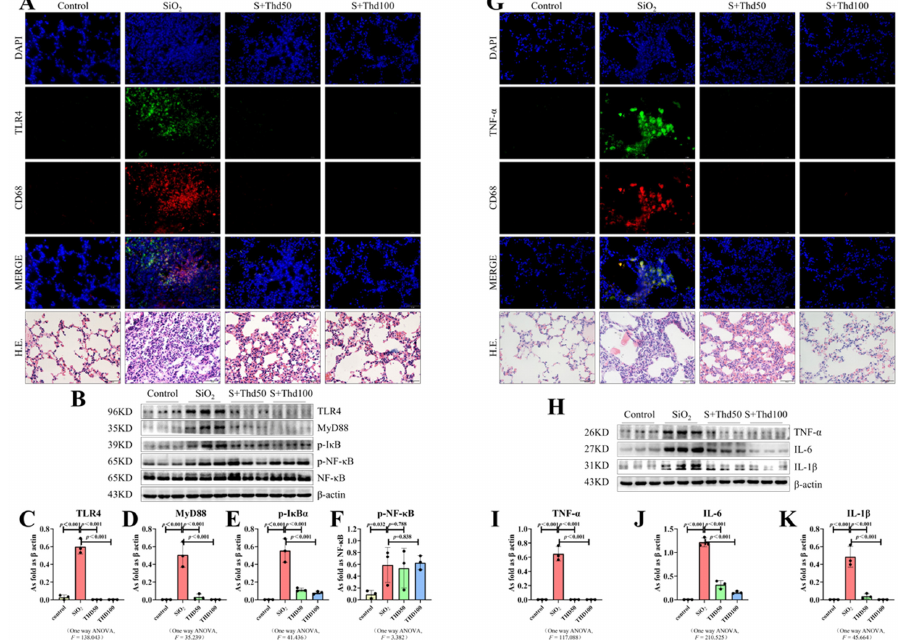
Figure 4. Thalidomide inhibited the expression of the TLR4 signal and inflammatory factors in silicosis mice. ( A , G ) Expression of TLR4 and TNF- α in silicosis mice measured by IF staining (scale bar = 50 µm). ( B – F , H – K ) Expression levels of TLR4, MyD88, p-I κ B α , p-NF- κ B, TNF- α , IL-6, and IL-1 β in the lungs of mice measured by Western blot. Data are presented as the mean ± SD, n = 3 per group.